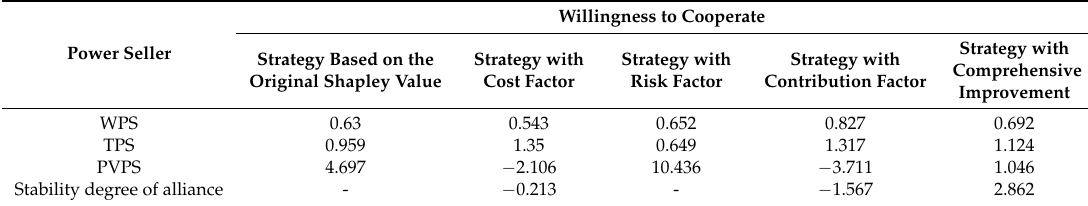
Table 10. The willingness to cooperate under different distribution